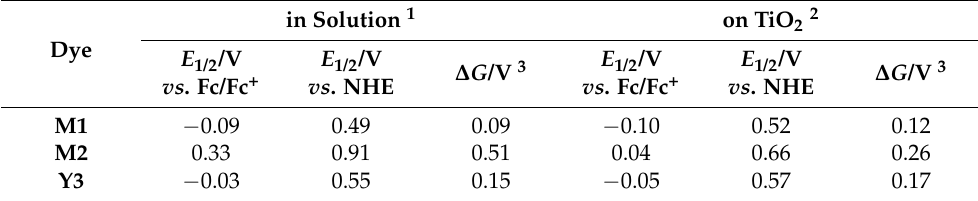
Table 2. Redox potentials and ∆ G values of M1 , M2 , and Y3